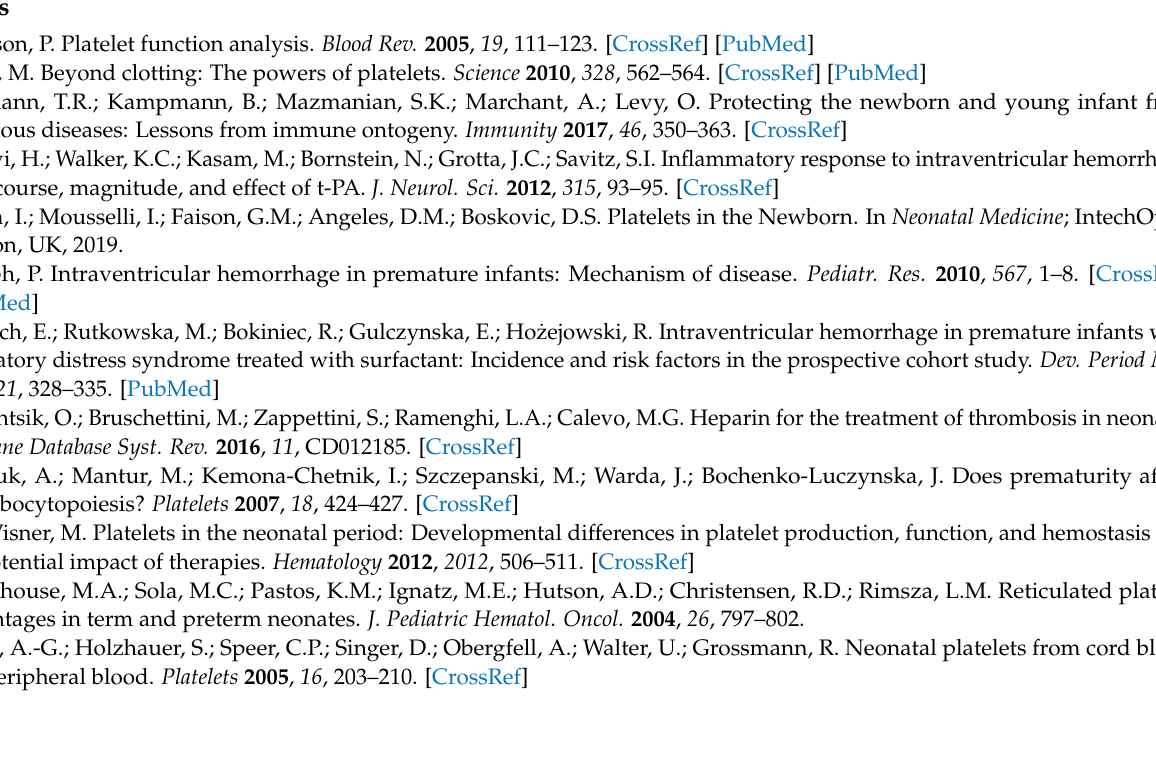
Figure 1: Blood-cell analysis of the immature platelet fraction (IPF) performed